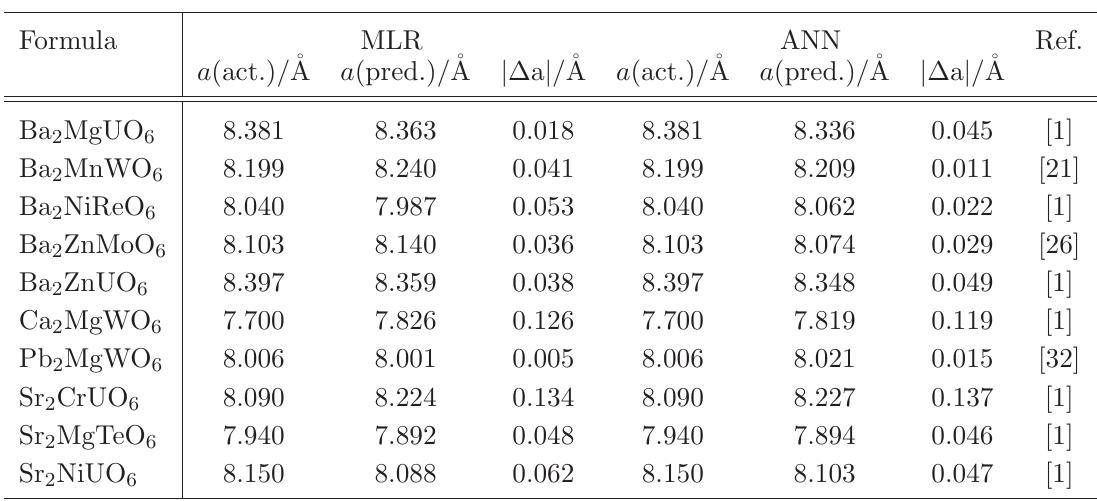
Table 4 (continue) Actual and predicted values for the unit cell edge length, as well as, absolute errors for the compounds of the test set obtained by MLR and